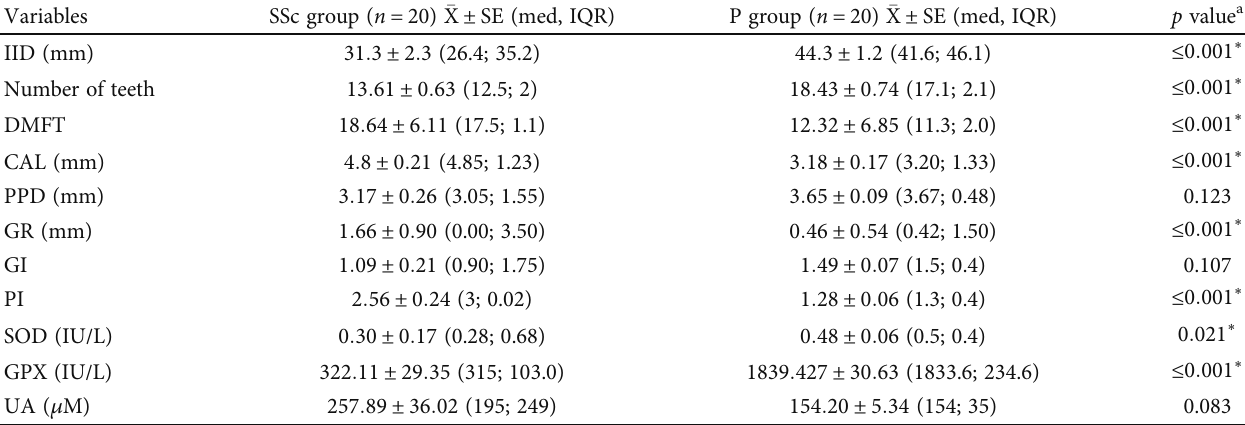
Table 2: Dental and periodontal fi ndings and antioxidant concentrations among the SSc and P groups. Variables